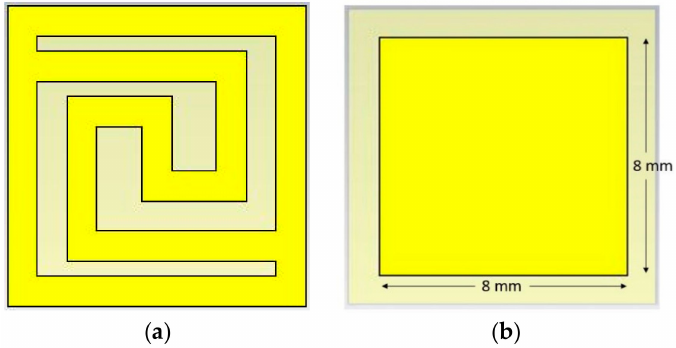
Figure 1. Design of the proposed unit cell ( a ) patch, ( b ) ground (for FR4 (Flame Retardant 4)